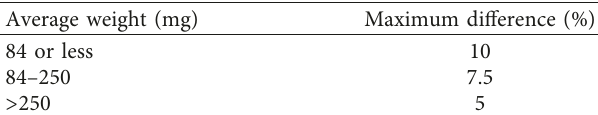
Table 6: Weight variation